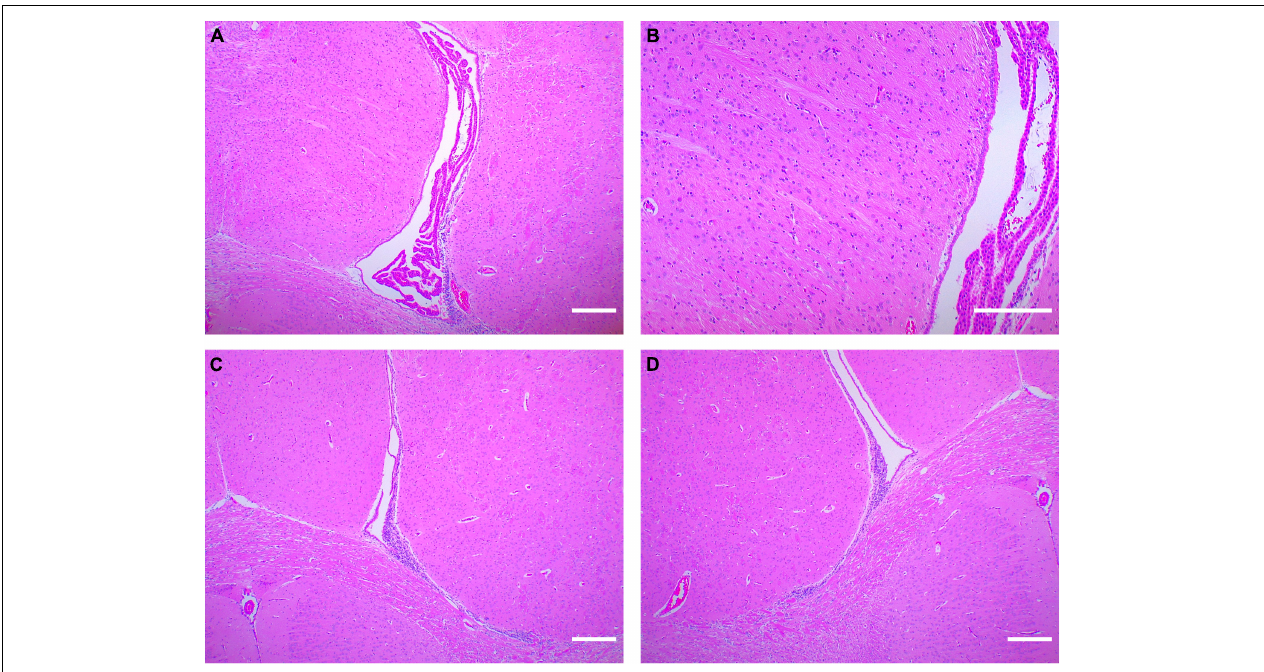
FIGURE 4 | Hematoxylin-eosin staining around the lateral ventricle in rats ( n = 2–3 brains per group). (A) The rats in the control group (P20) had normal lateral ventricles, developed choroid plexus, and abundant and orderly nerve fibers in the white matter adjacent to the lateral ventricles. (B) Periventricular white matter at 4 × magnification. (C,D) In the WMI group (P20), lateral ventricle development was slower, choroid plexus atrophy and nerve fibers were sparse. Scale bar = 200 µ